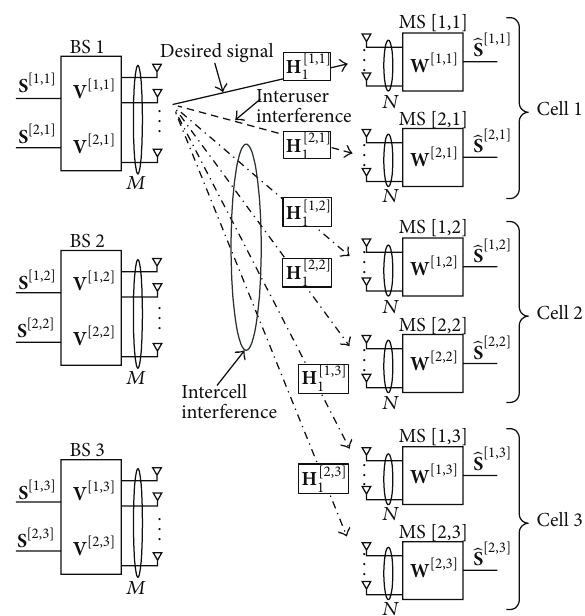
Figure 1: MIMO-IFBC for the case of three cells and two users per cell ( 𝐿 = 3 and 𝐾 = 2